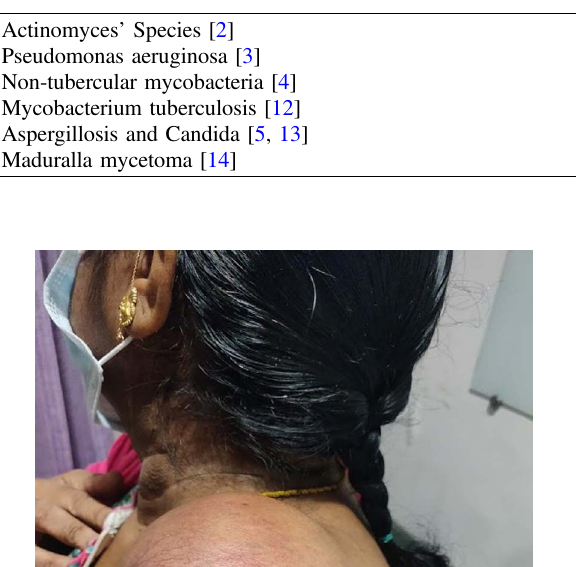
Table 1. Rare organisms infecting operated joints.